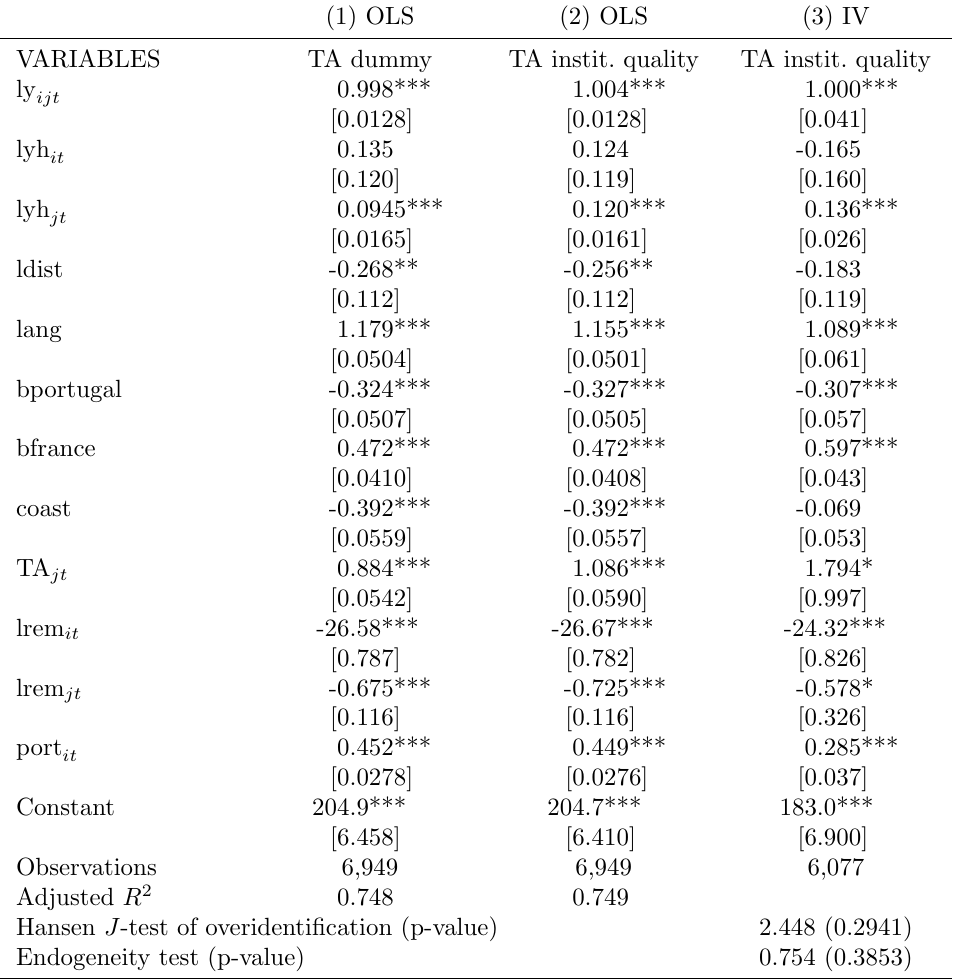
Table 1: Results of the estimation. Equation